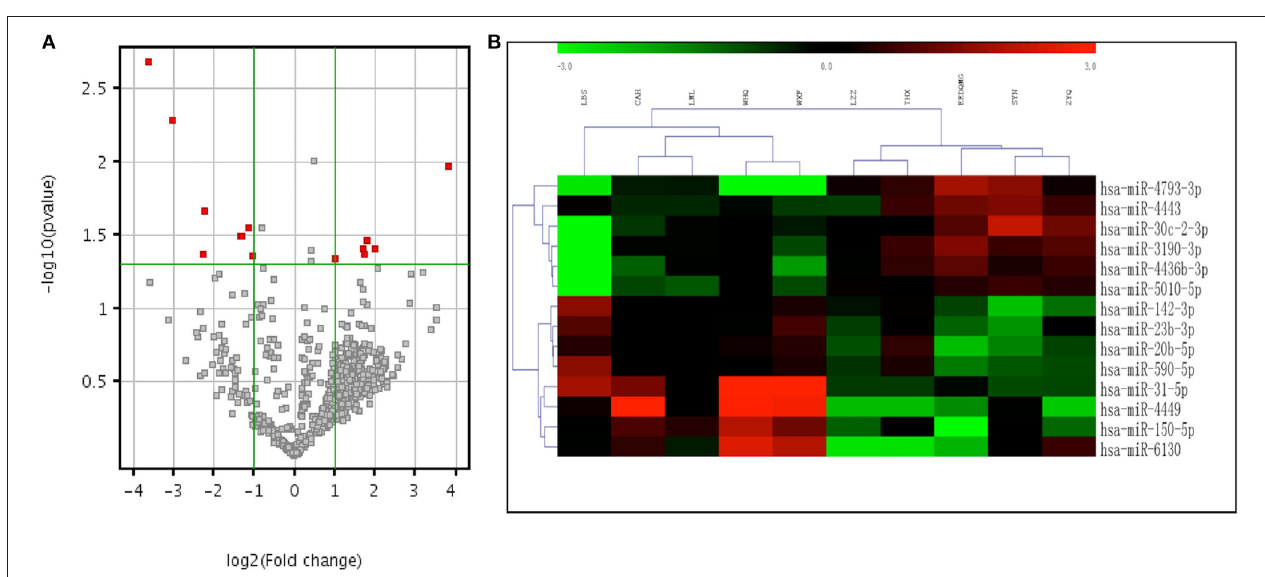
FIGURE 2 | Volcano plot and heatmap expression profiles of differentially expressed miRNAs between aSAH patients and controls in the screening stage. (A) Volcano plot of all miRNAs. The –log (P) of each miRNA is plotted against the log2 ratio of aSAH intensity to normal intensity. The green horizontal line indicates the significance level at P = 0.05. The green vertical line indicates a fold change level > 2. miRNAs that were significantly up-regulated or down-regulated in aSAH patients are indicated by red dots. (B) Two-way hierarchical clustering of 14 significant miRNAs. Relatively higher expression levels are represented by red, and relatively lower expression levels are represented by green. miRNAs indicate microRNAs and aSAH, aneurysmal subarachnoid